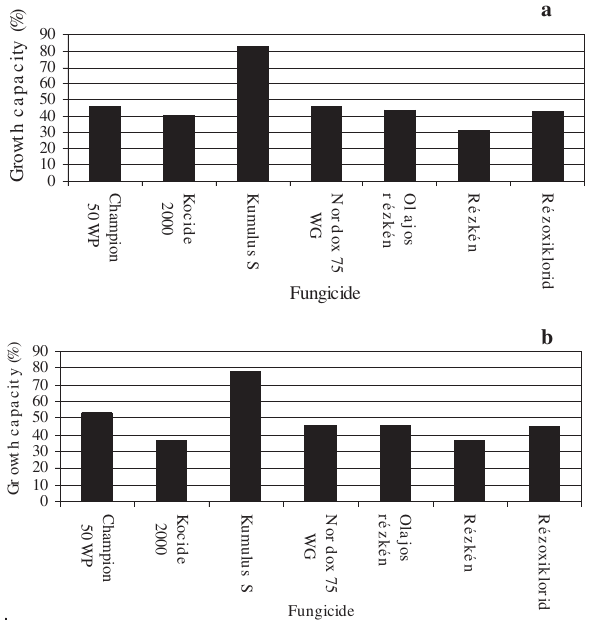
Figure 3. Percent growth capacity of two Monilinia laxa isolates (a and b) for 7 fungicides (organically approved) admended on PDA plates at 0.5 x dosage recommended by the manufacturer